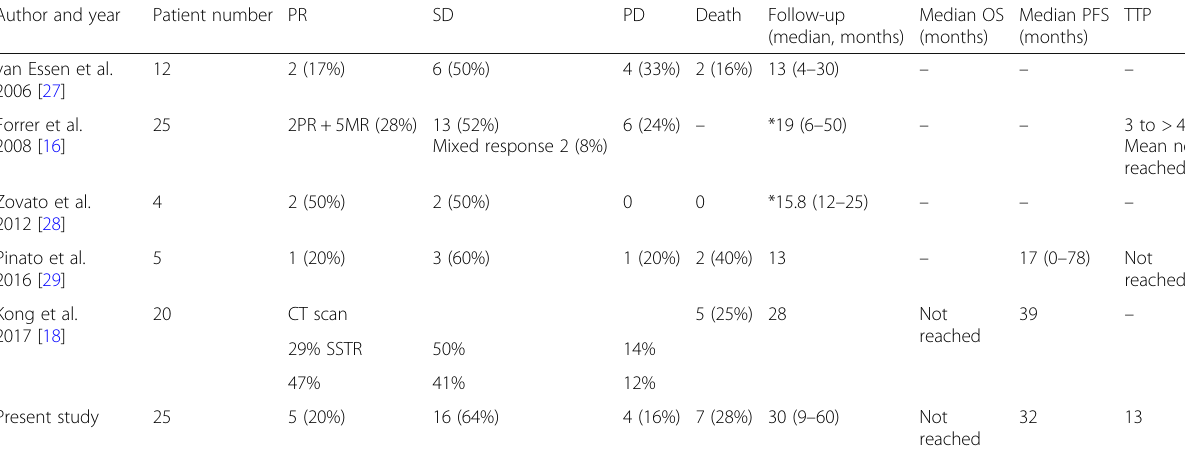
Table 7 Comparison of various reports on the efficacy of PRRT in PGL/PCC patients Author and